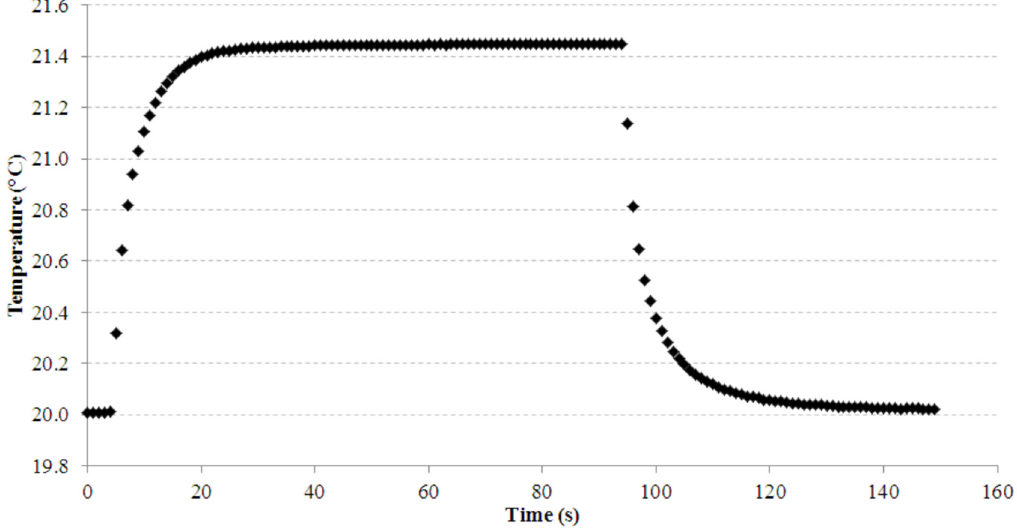
Fig. 2. Temperature monitoring during a measurement